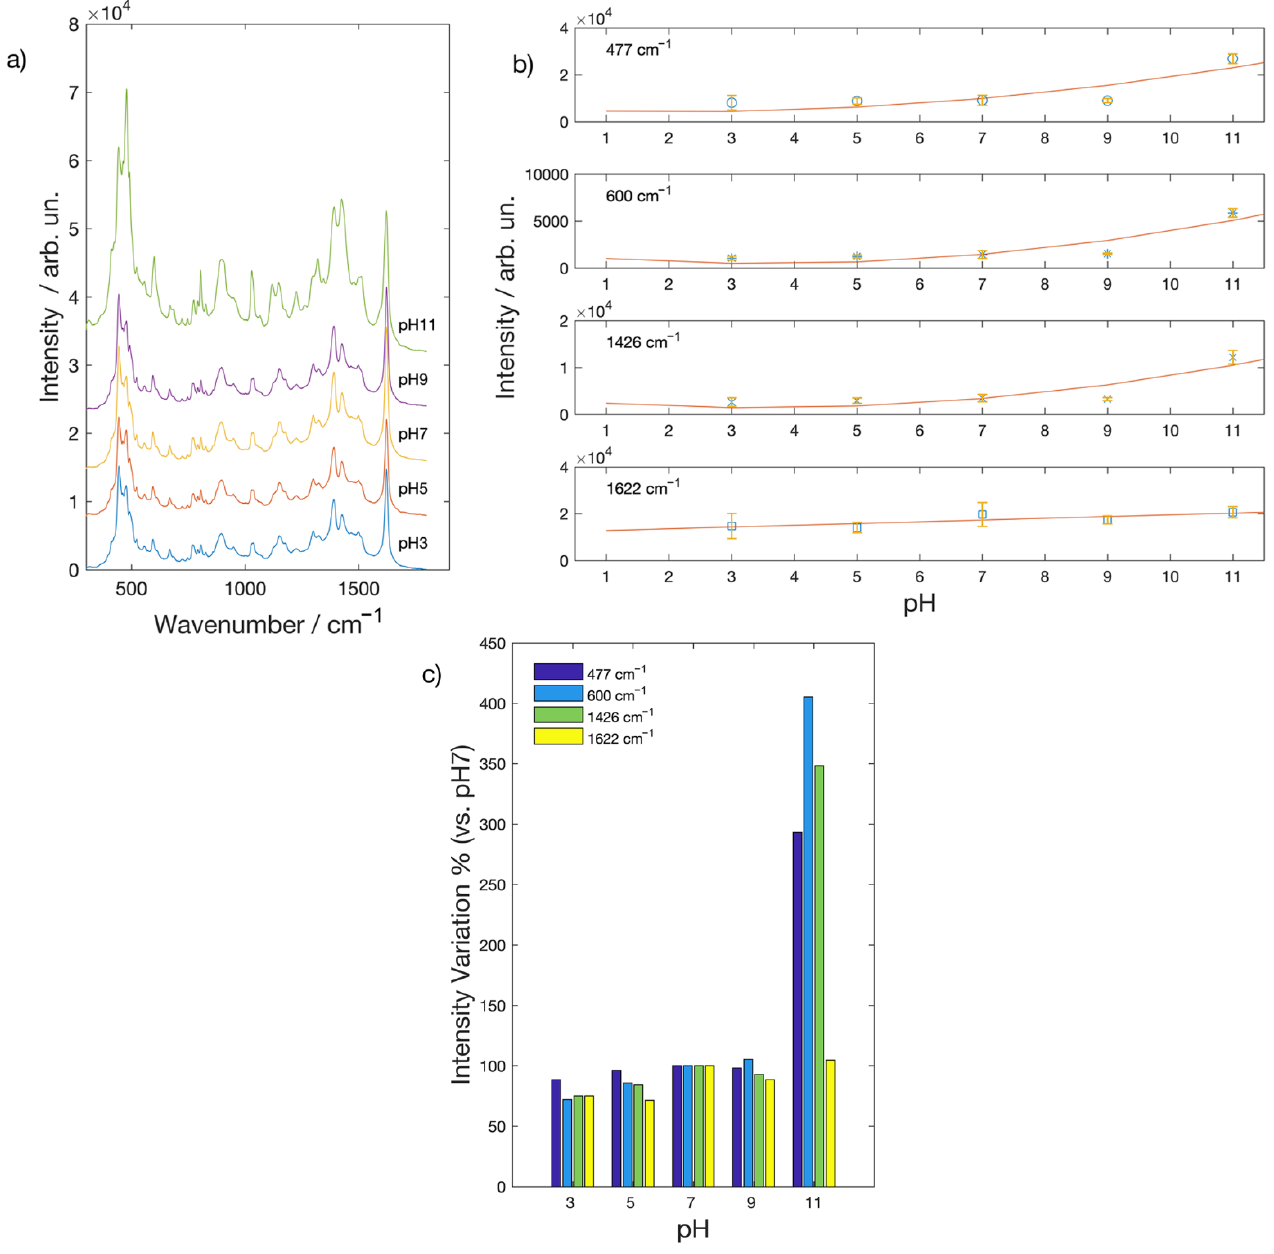
Figure 2. ( a ) SERS spectra of a MB 2.5 × 10 − 4 M solution at different pH values acquired on Ag SERS active substrates; ( b ) intensity behavior of some MB Raman peaks as function of the pH (lines are a guide for the eye); ( c ) intensity variation of Raman peaks in % with respect to the value at pH = 7.